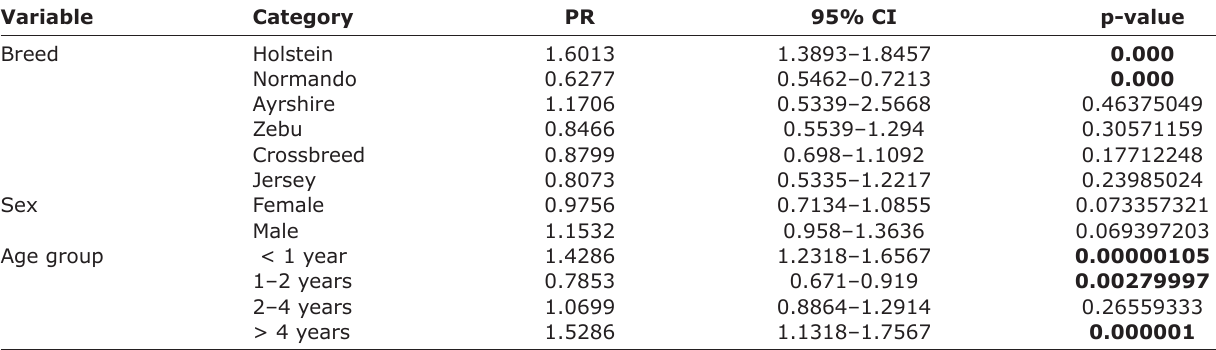
Table-3: Analysis of breed, sex and group age as possible risk factors associated with IBR infections. Results are shown as PR and 95% CI. Variable